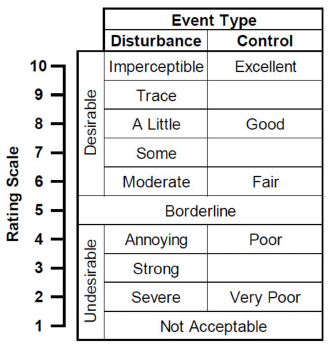
Figure A1. Subjective rating scale